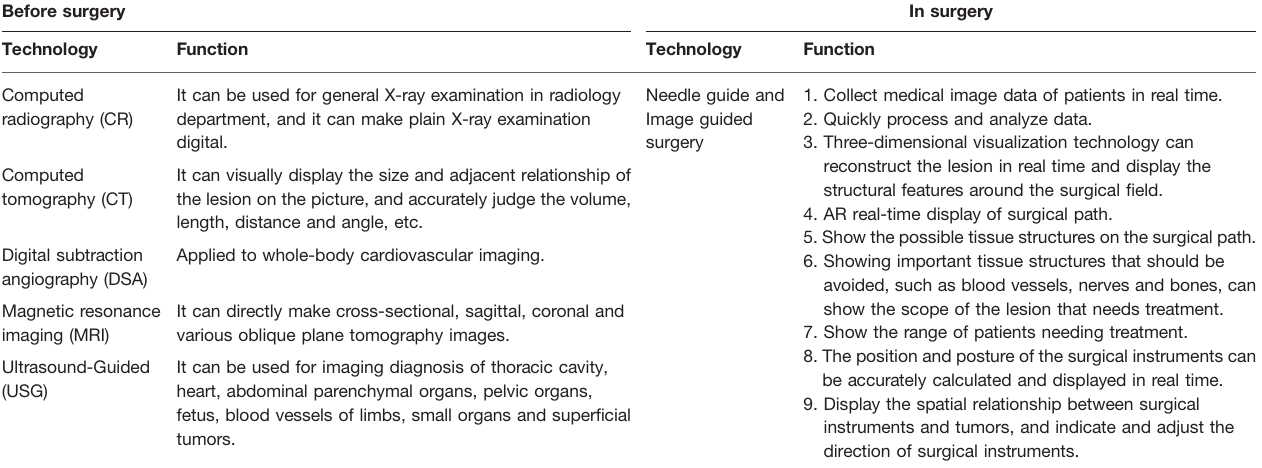
TABLE 1 | Application of medical imaging in